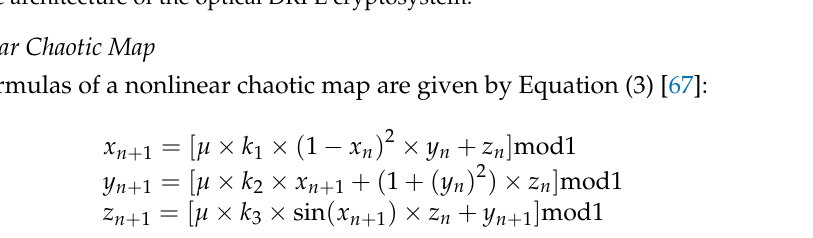
Figure 1. The architecture of the optical DRPE cryptosystem.